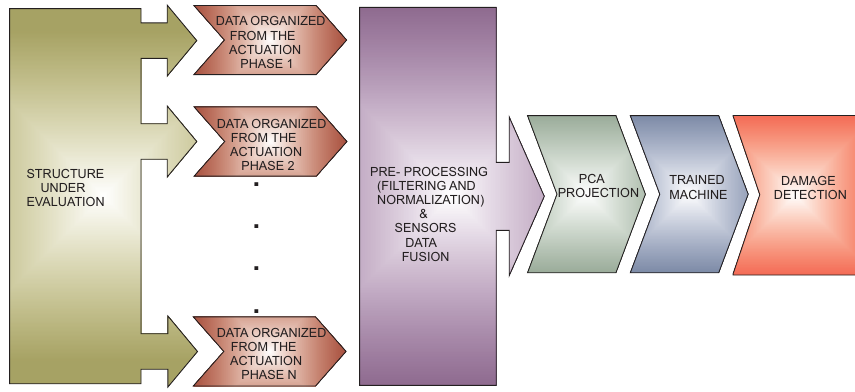
Figure 9. Testing step with data from the structure in an unknown structural